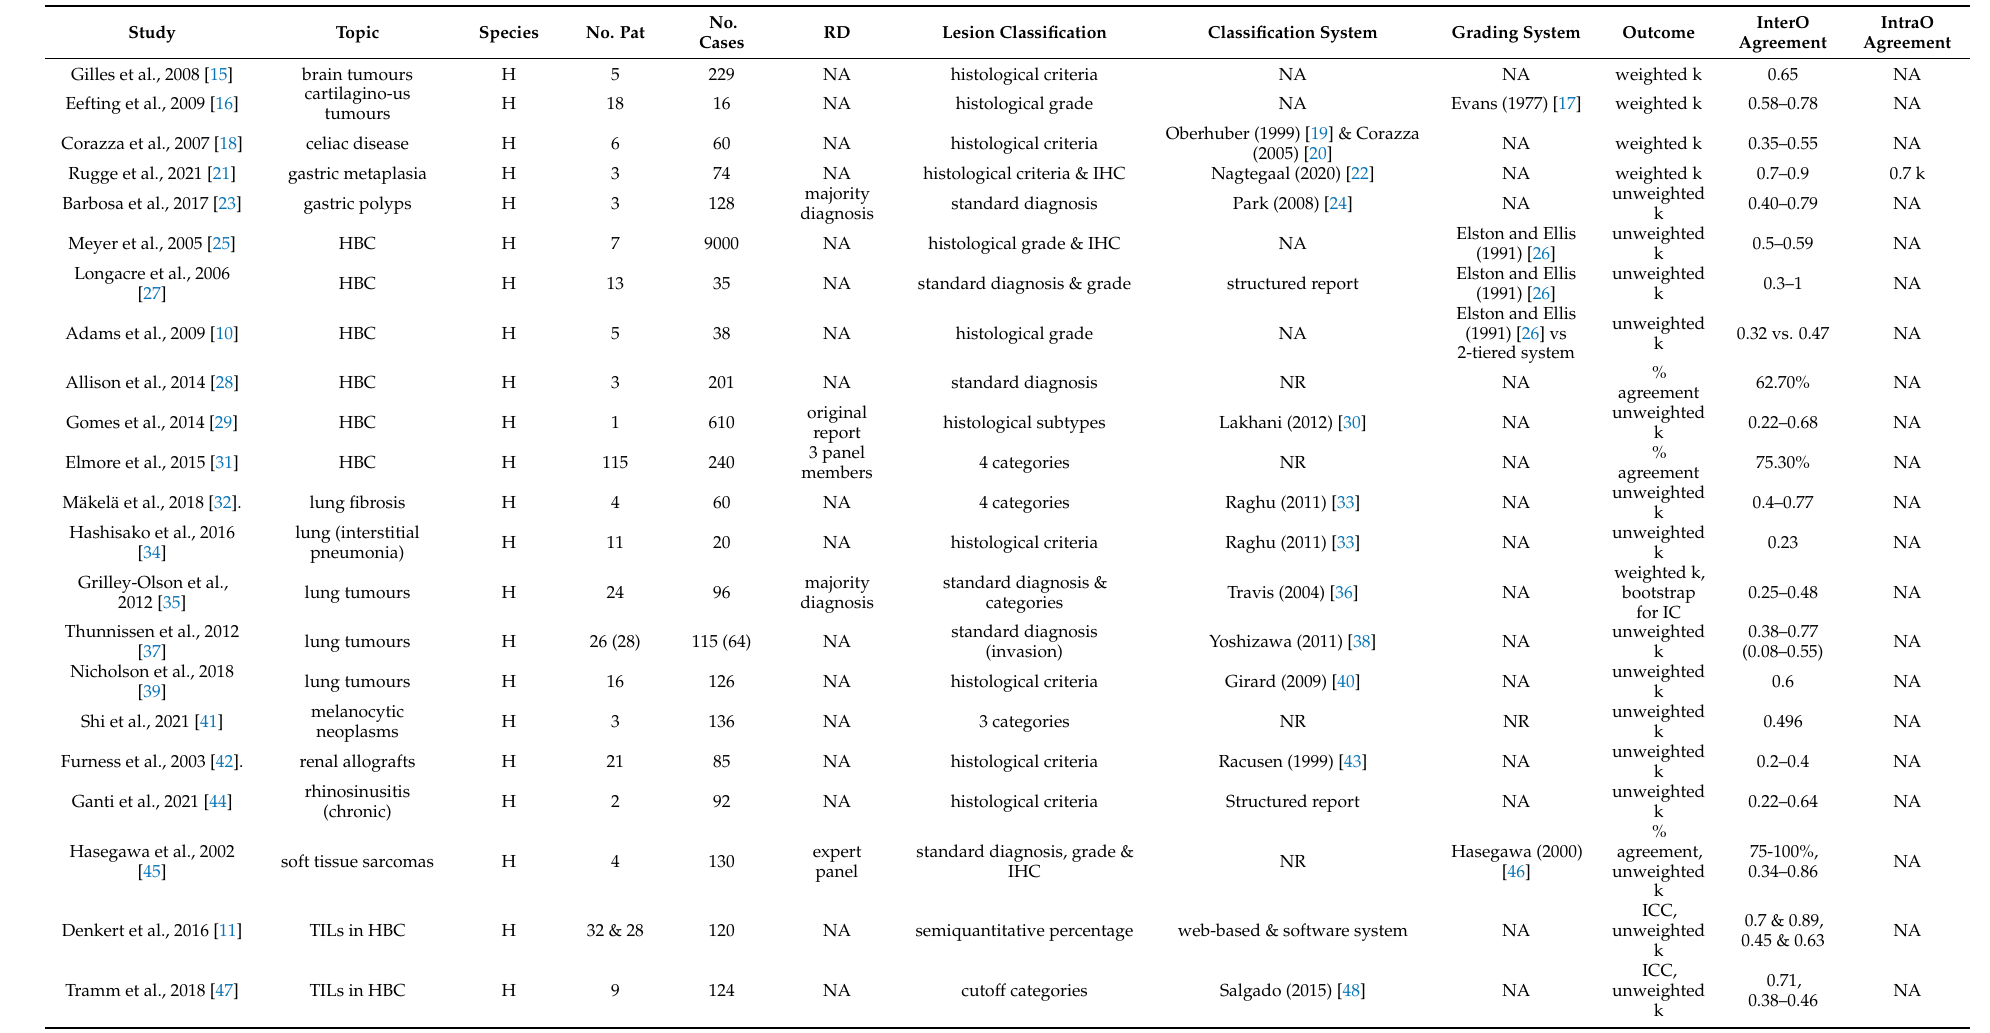
Table 1. Scientific studies dealing with inter- and intraobserver variability in the pathological diagnosis (references are listed in alphabetical order for the topic, separately for humans and